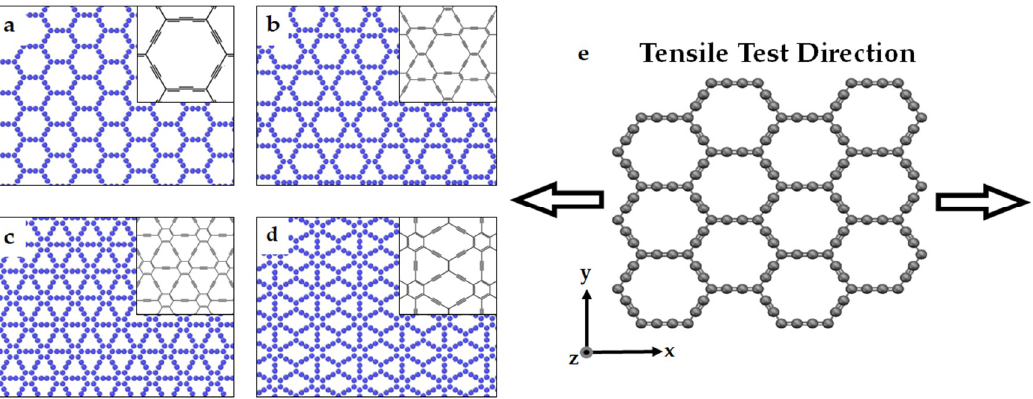
Figure 1. The structure of four types of graphyne and the schematic diagram of the tensile test: ( a ) α -graphyne; ( b ) β -graphyne; ( c ) δ -graphyne; ( d ) γ -graphyne; ( e ) schematic diagram of the tensile test.